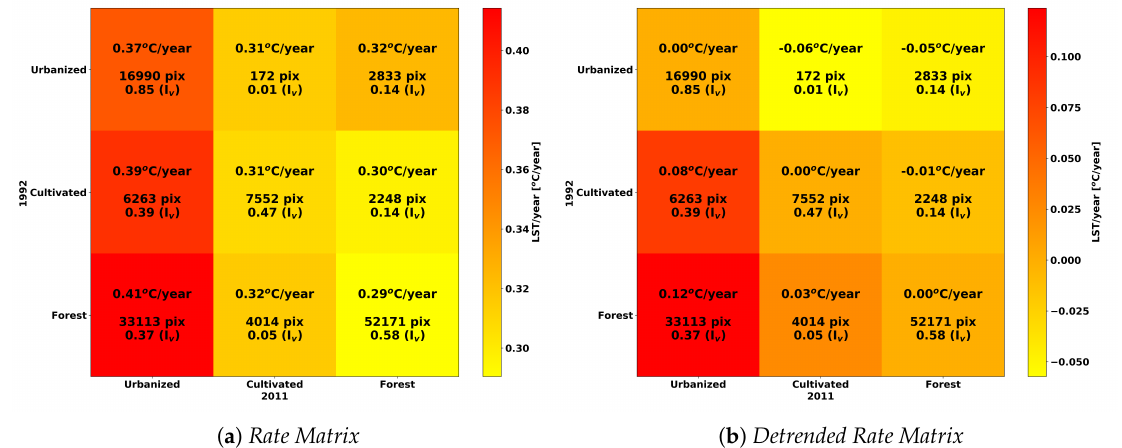
Figure 7. Atlanta MA: Rate and Detrended Rate Matrices